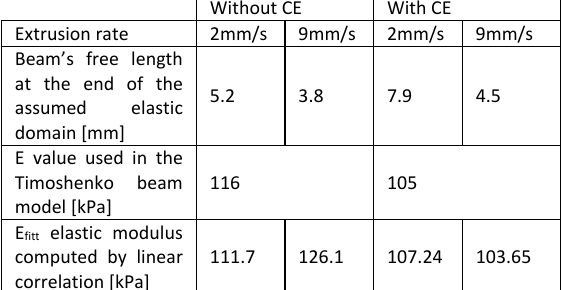
Table 1. Summary of measured apparent elastic moduli Without CE With CE Extrusion rate